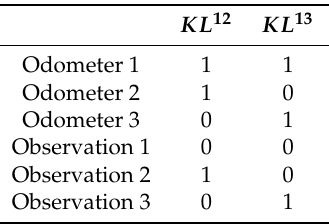
Table 1. The signature matrix of robot 1 for